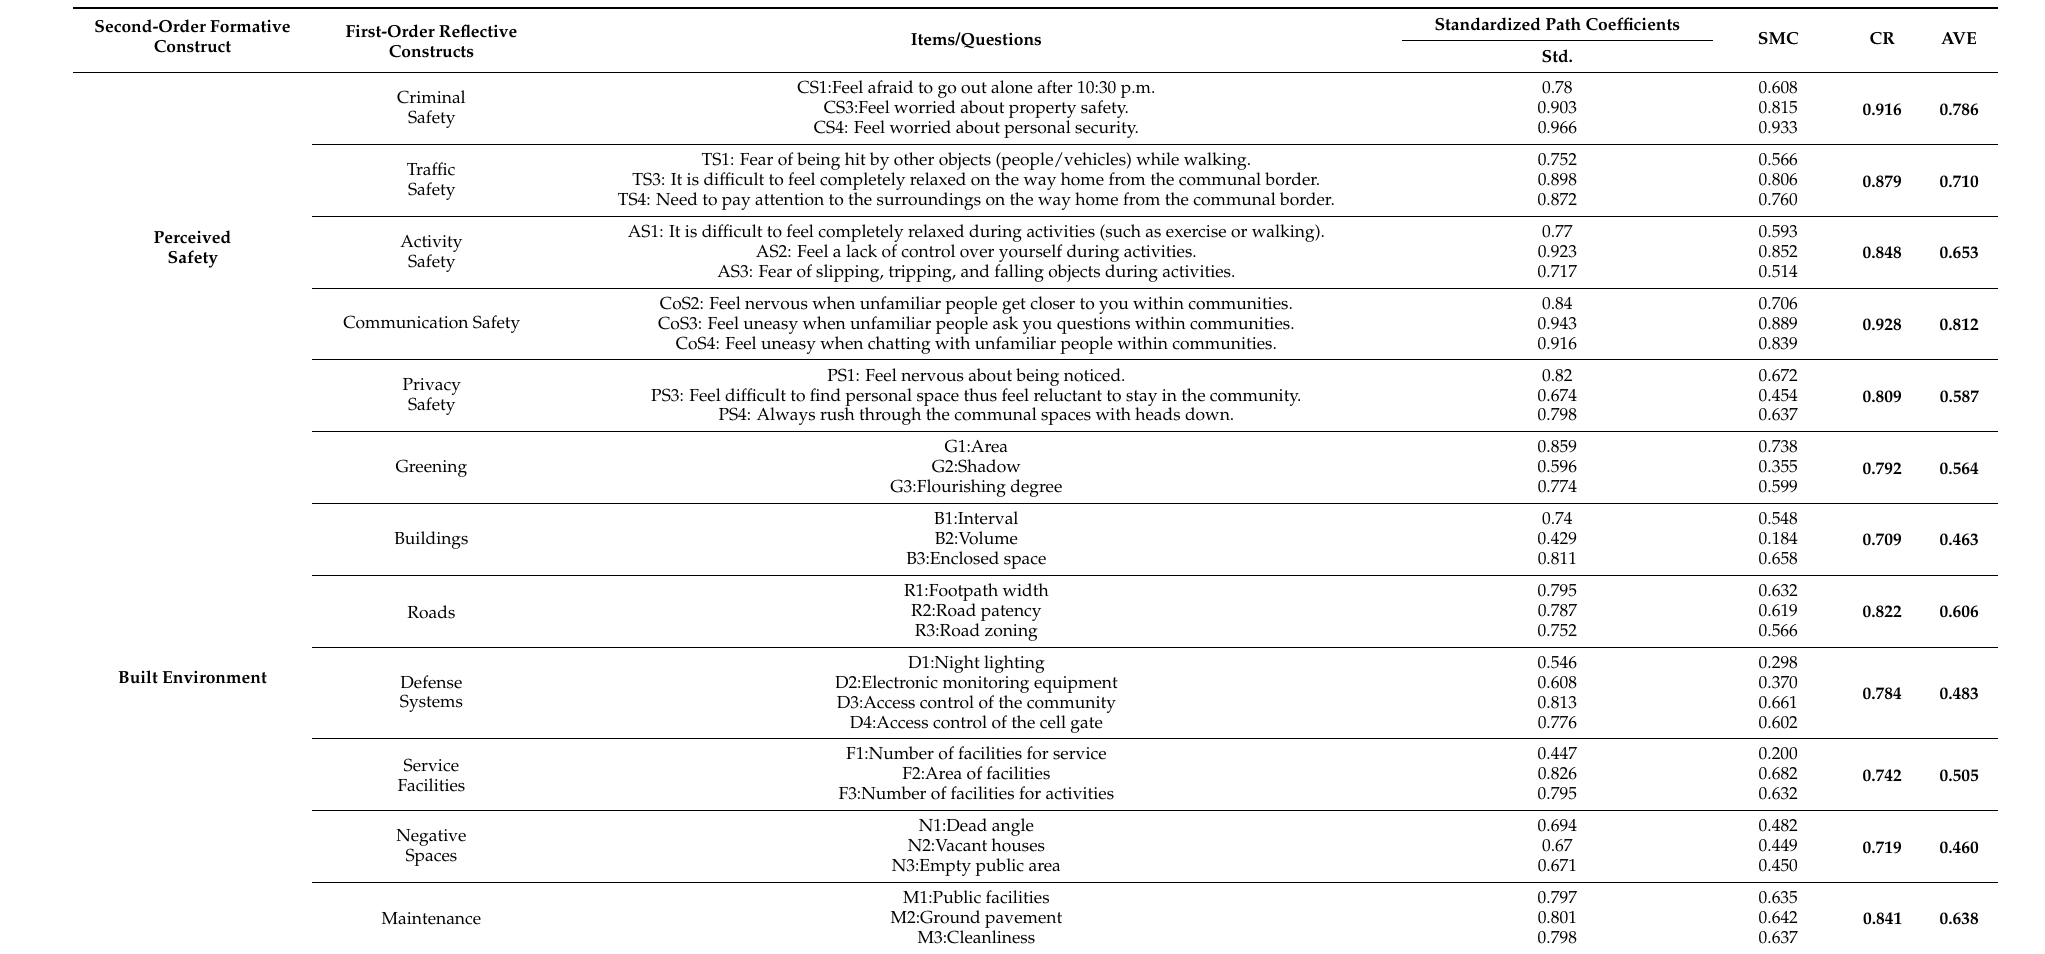
Table 1. Factor loadings of selective items in CFA and reliability-validity